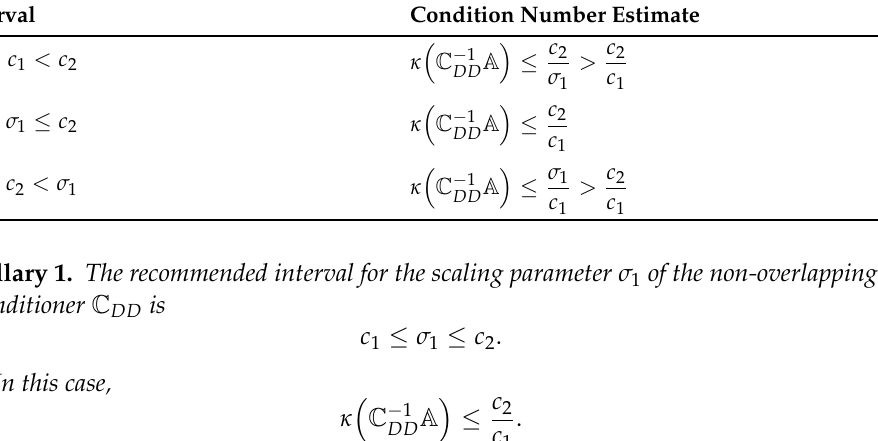
Table 1. Dependence of the estimate of κ Interval Condition Number